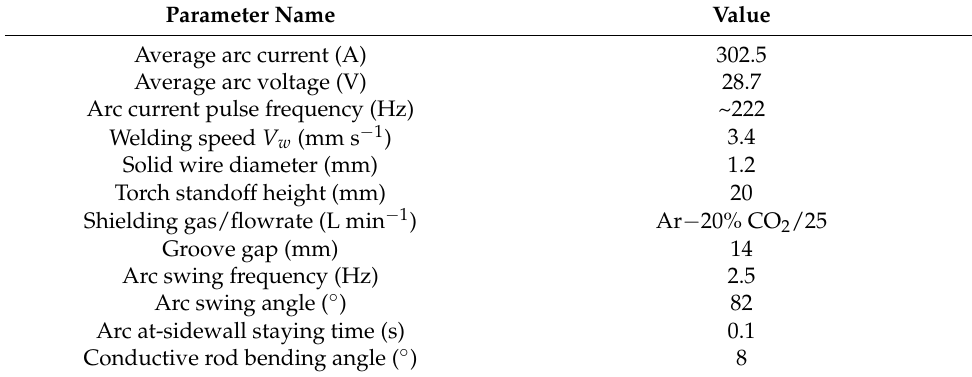
Table 2. Welding experimental